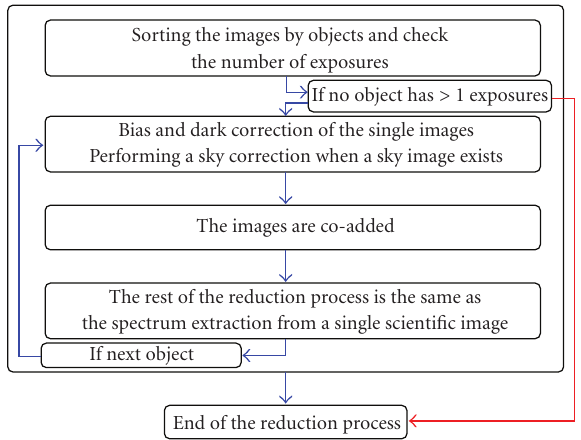
Figure 7: Flow chart of the first steps of the spectrum extraction of the coadd science images.